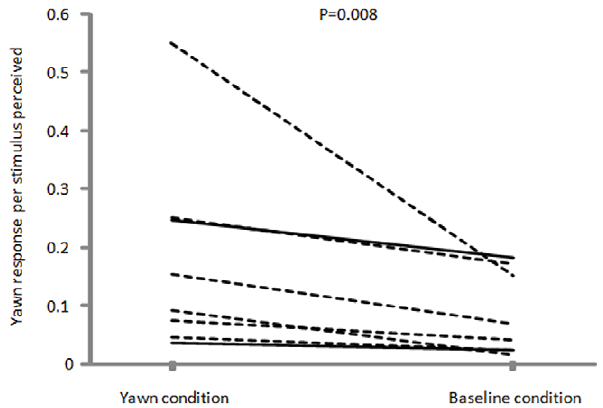
Figure 1. Yawn contagion in bonobos: individual frequency of yawns in presence (yawn condition) and in absence (baseline condition) of the stimulus (triggering yawn). Dotted lines represent females, full lines represent males.